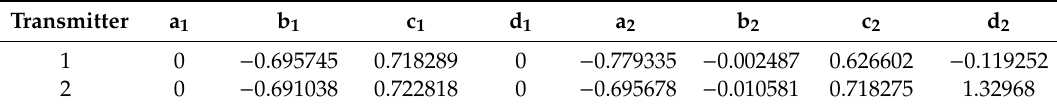
Table 1. The initial intrinsic parameters of the two transmitters.